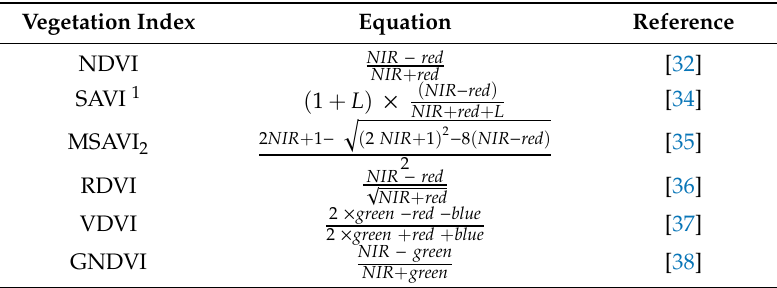
Table 2. Vegetation indices and the associated formulas used in the analysis. Vegetation